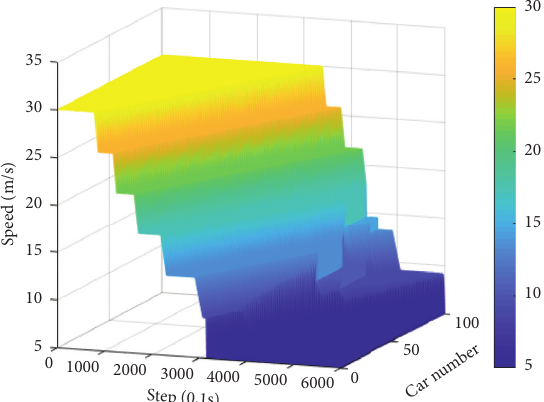
Figure 4: Illustration of the gradual deceleration process of the proposed CAV-VSL control.